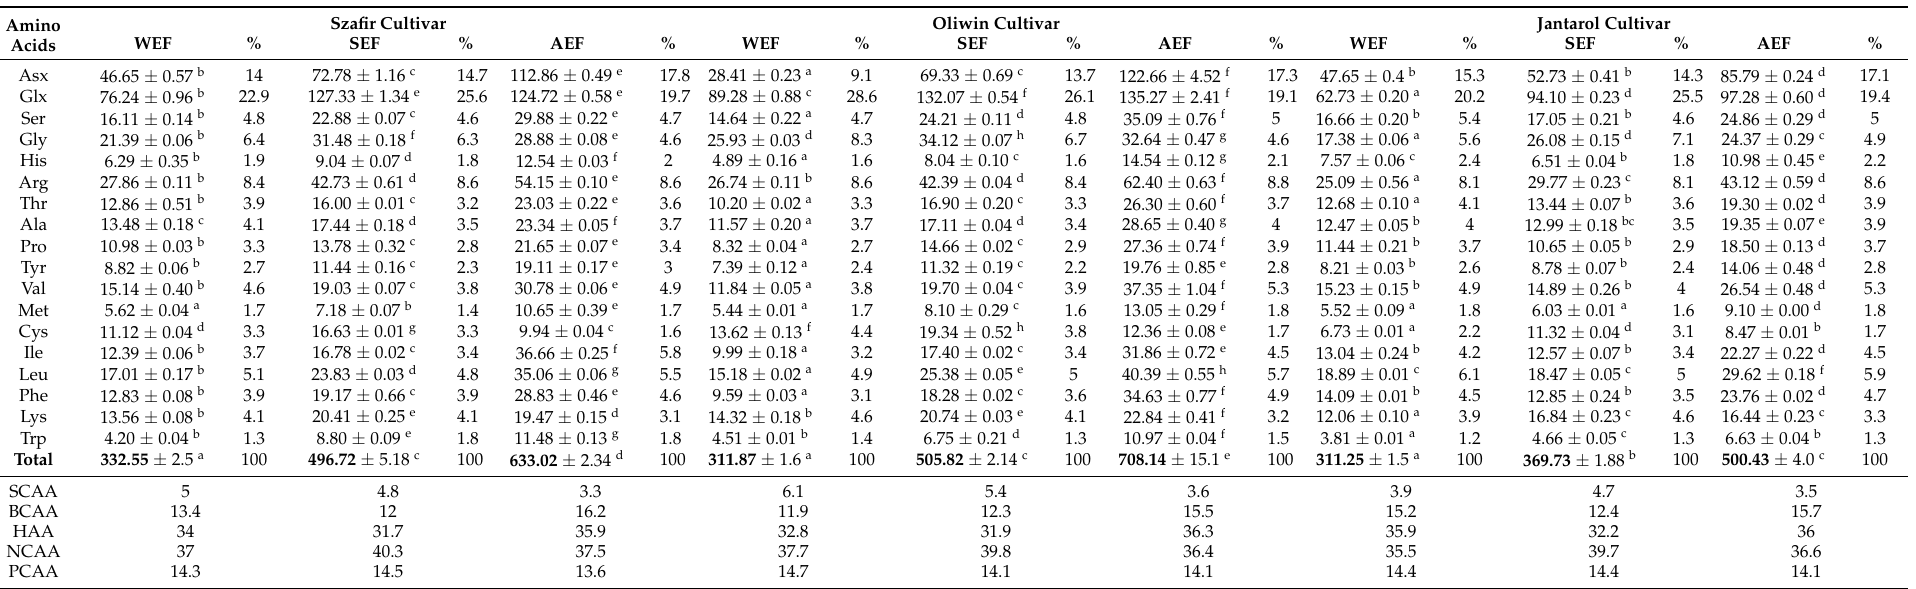
Table 1. Amino acid composition (mg g − 1 ) of the flaxseed protein